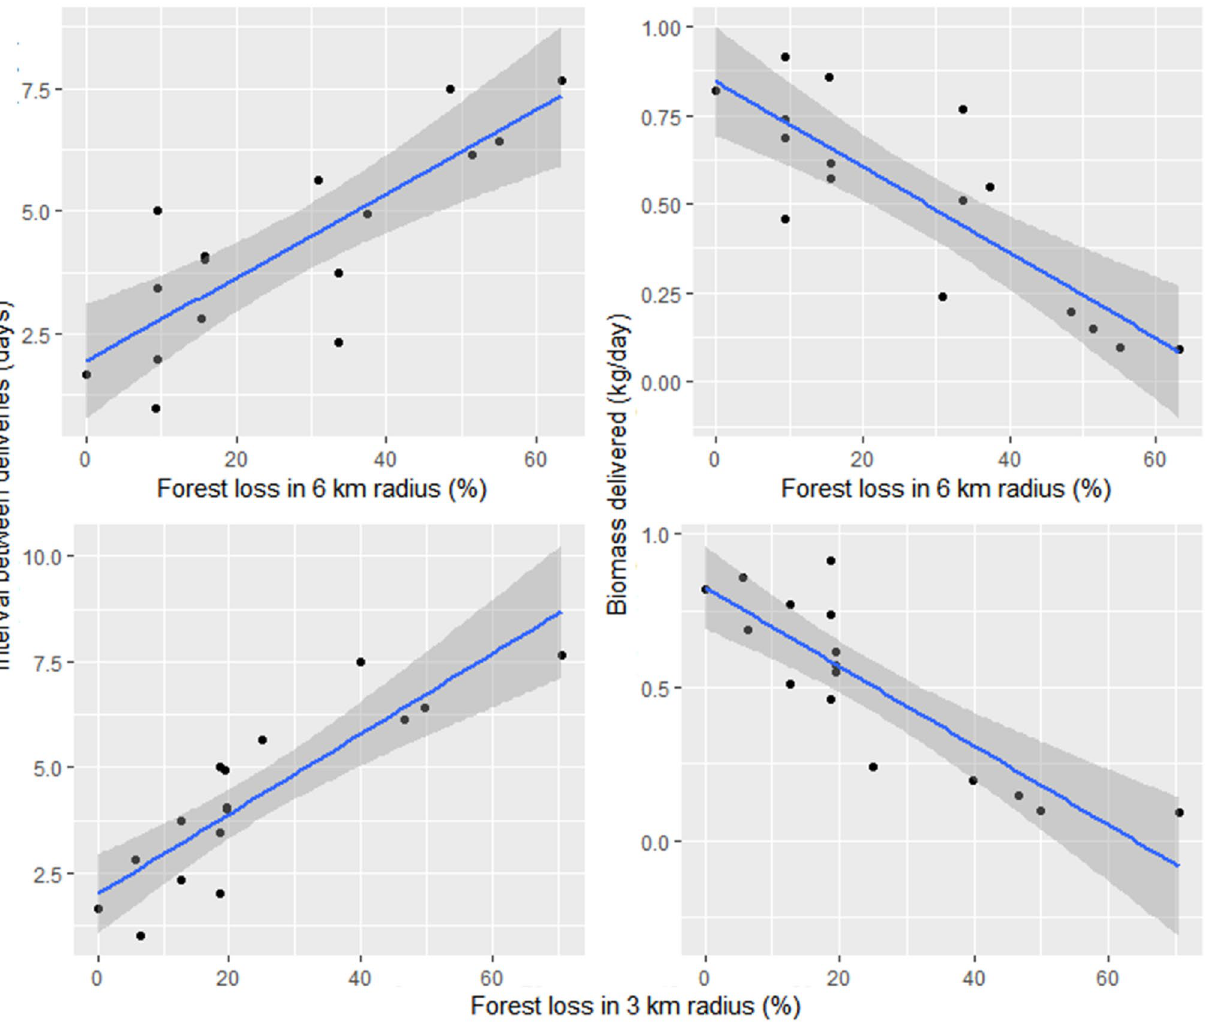
Figure 7. Effects of forest habitat loss on the feeding ecology of harpy eagles, as depicted by 16 nest-phases. Habitat loss reduced the frequency of prey delivery (right panels) as well as the prey biomass delivered to the nest (left panels). These slopes were significant in all